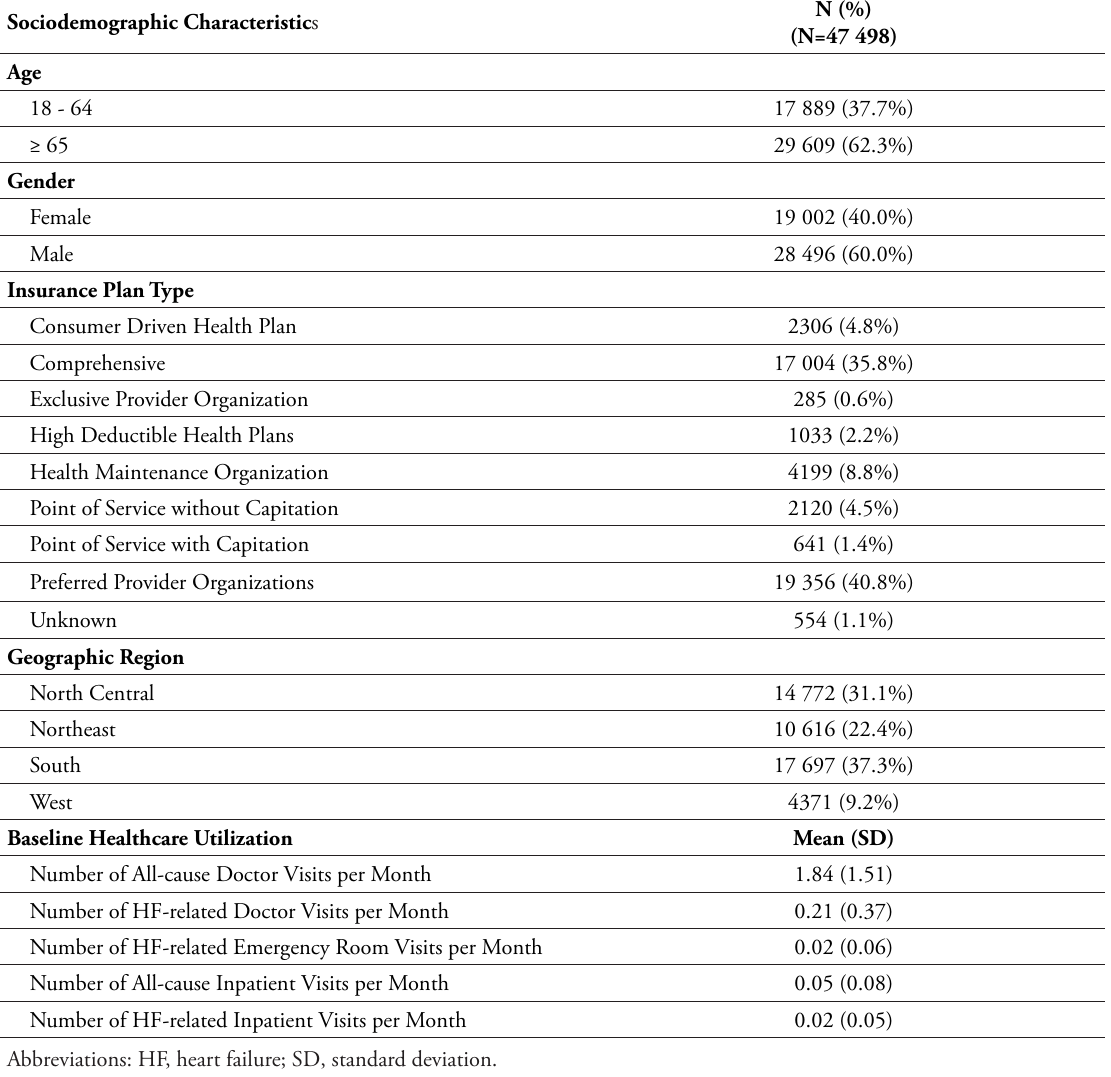
Table 1. Characteristics of Patients with Heart Failure with Reduced Ejection Fraction (HFrEF) Sociodemographic Characteristic s